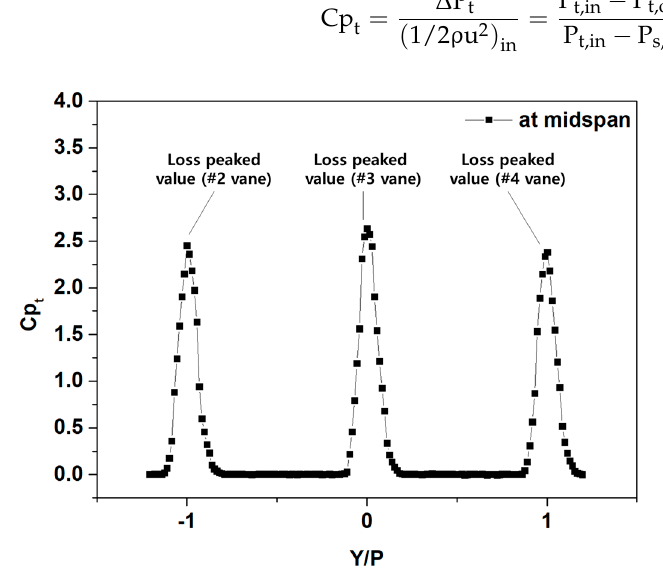
Figure 4. Periodicity of the cascade mainstream.